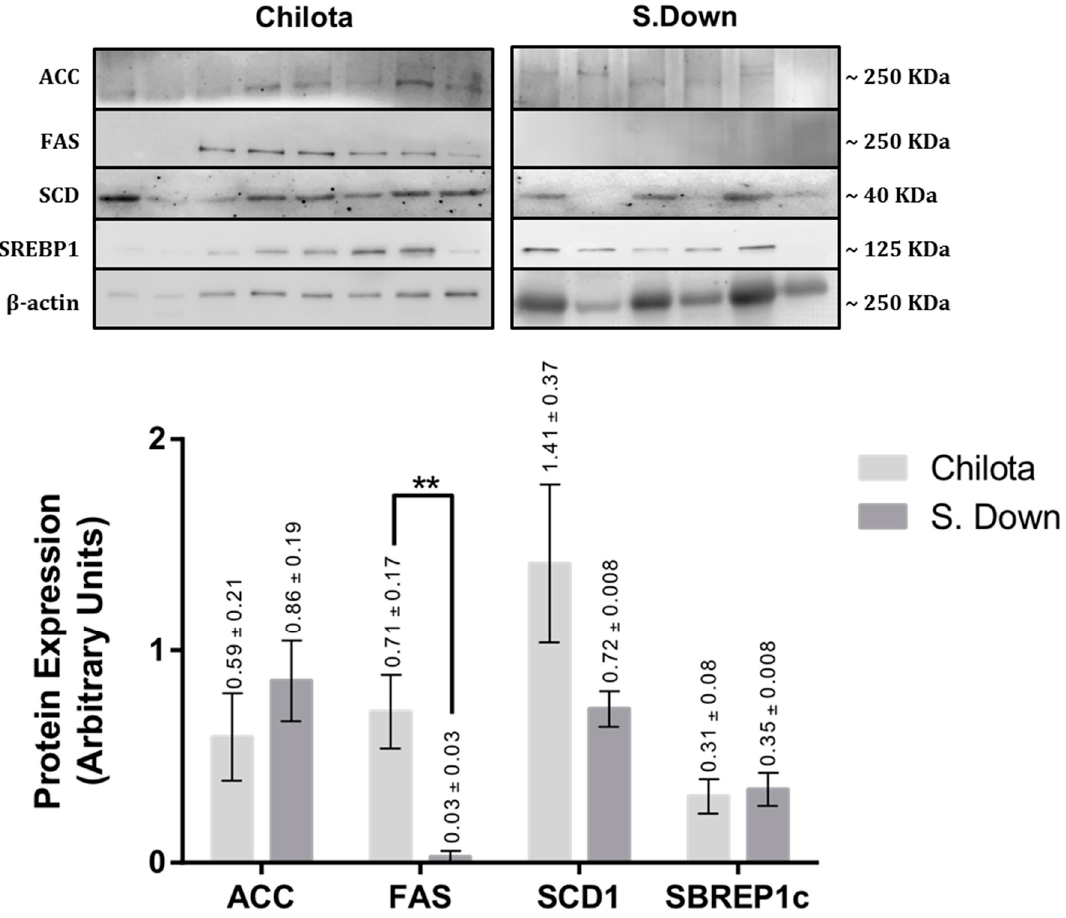
Figure 1. Protein expression levels of ACC, FAS, SCD1, and SREBP1c in subcutaneous fat from Chilota ( n = 8) and Suffolk Down lambs ( n = 6) grazing Calafatal pasture; analyzed by western blot. The LSM ± SEM values are shown above each bar of the graph. Normalized to β actin expression; ** p < 0.05.